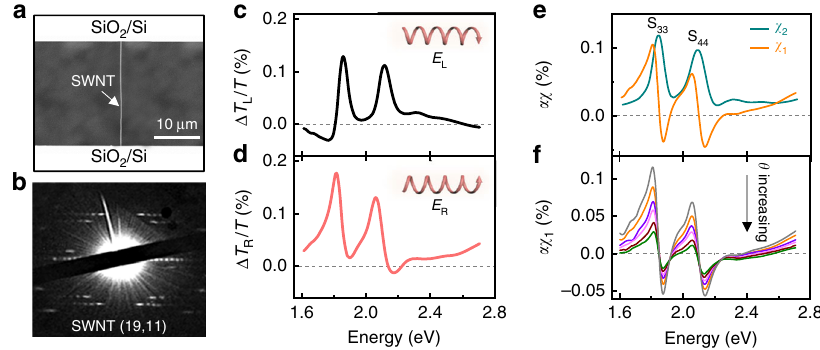
Fig. 2 Complex optical susceptibility measurement of individual suspended nanotube. a Scanning electron micrograph (SEM) image of a suspended carbon nanotube across an open slit etched on SiO 2 /Si substrate. b The electron diffraction pattern reveals the chiral index of nanotube as (19, 11), a semiconducting tube with a diameter of 2.06 nm. c , d Optical contrast spectra with left- ( E L ) ( c ) and right-handed ( E R ) ( d ) elliptically polarized excitation. The angle θ between the wave plate and polarizer 1 or polarizer 2 is set as 2°. e Real ( αχ 1 , orange line) and imaginary ( αχ 2 , green line) susceptibility of the nanotube under θ = 2°. The two peaks are corresponded to S 33 and S 44 optical transitions, respectively. f Dependence of detected real susceptibility value ( αχ 1 ) on θ . With θ increasing from 1.4° to 4°, the signal decreases linearly with 1/sin2 θ (Supplementary Fig. 1). α is a detection coef fi cient nanotube suspended across an open slit in SiO 2 /Si substrate is under left- (Fig. 2c) and right-handed (Fig. 2d) elliptically shown in Fig. 2a. The chiral index of this nanotube was identi fi ed polarized light excitation ( θ = 2°). This set of spectra show two as (19, 11) from its electron diffraction pattern (Fig. 2b) and its characteristic features, which are signi fi cantly different from Rayleigh scattering or absorption spectrum 37 . Figure 2c, d shows absorption spectra 26 : (1) the peaks are not Lorentzian like, with optical contrast signals in photon energy range of 1.60 – 2.70 eV slow bumps and pits; (2) optical contrast signal goes below zero at